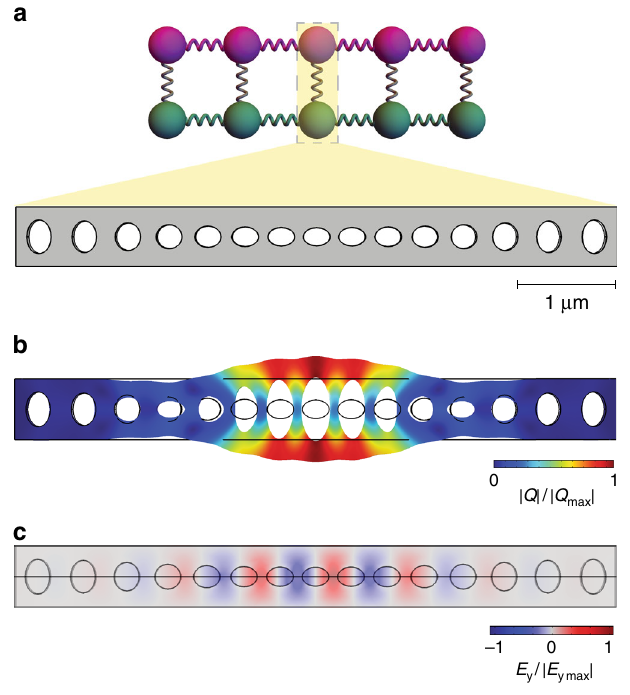
Fig. 2 The portion of an optomechanical crystal corresponding to a single site in the tight-binding model. a The correspondence between the ball and the physical realization (expanded view). b The same portion of the optomechanical crystal showing the normalized mechanical displacement (| Q |/| Q max |) of a con fi ned eigenmode, and c , the normalized electric fi eld (cid:5) (cid:5) (cid:5)(cid:6) (cid:7) (cid:5) E y = E y of an eigenmode. The frequencies and coupling strengths can max be calculated using fi nite-element (FEM) simulations (see Supplementary Note